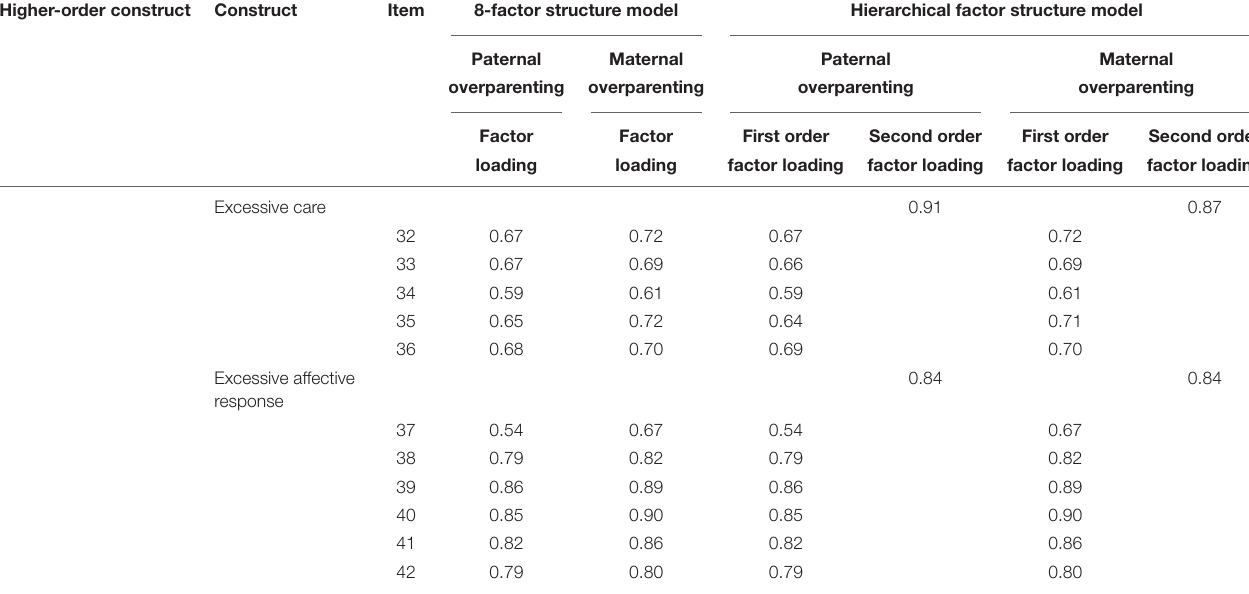
TABLE 7 | Correlations of Chinese paternal/maternal overparenting scales and their